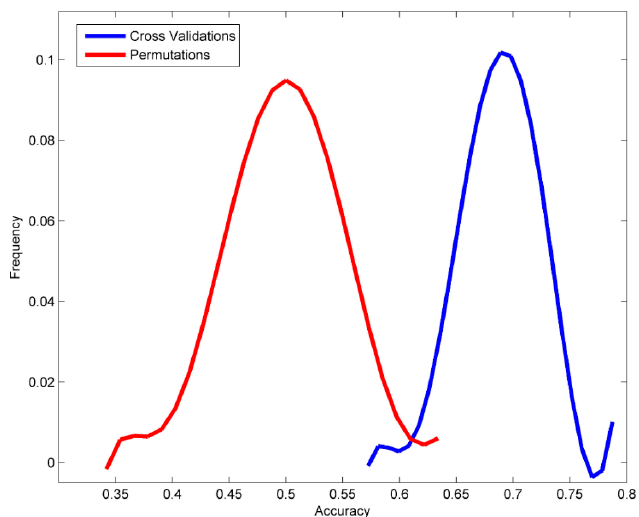
Figure 3. Distributions of the 1000 prediction accuracy values calculated from the DF models in permuation tests (red line) and yielded from the DF models in the cross validations (blue line). Prediction accuracy was calculated for the predictions in each of the 20 groups. The numbers of predictions, correct predictions and incorrect predictions for the 20 groups were shown as blue, red and green distribution curves respectively in Figure 4.